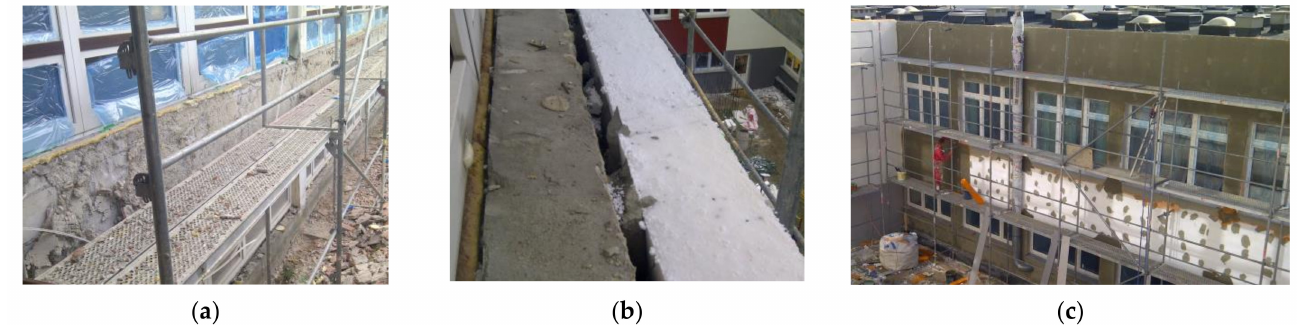
Figure 15. Examples of photos from the thermomodernization stage of the building: ( a ) uneven wall; ( b ) the gap between the polystyrene and the wall; ( c ) point thermal bridges [photo authors]. In accordance with relationship (9), the theoretical indicator and real indicator of demand for non-renewable primary energy EP [kWh · m − 2 · year − 1 ] before and after H ( A ) 0,1 thermomodernization were calculated, the values of which are presented in Table 10. Table 10. Theoretical and real indicator of non-renewable primary heating energy EP H ( A ) 0,1 before and after thermomodernization in 2017–2020 in building